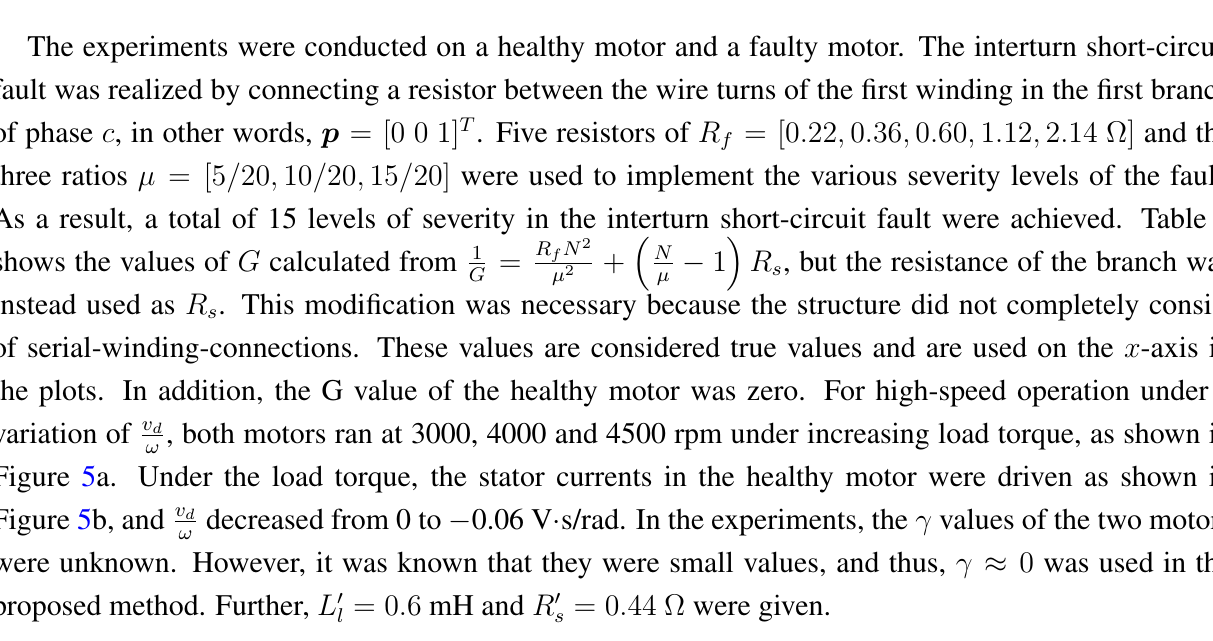
Figure 4. The experimental platform.